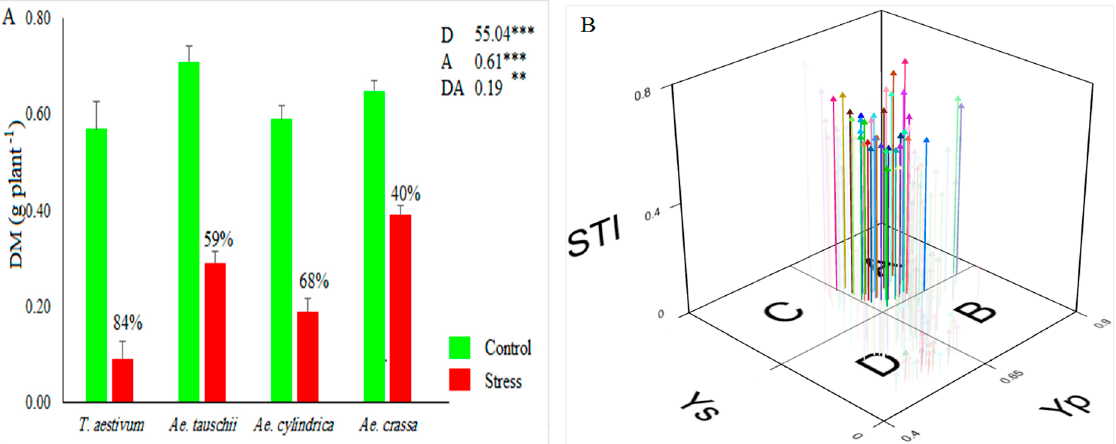
Figure 2. ( A ) Mean value for dry matter (DM) and ( B ) 3D-plot rendered based on dry matters under the control and drought stress conditions (Yp and Ys). ns, **, and *** indicate not significant, significant at p < 0.01, and significant at p < 0.001, respectively. D, A, and DA indicate drought treatment, accessions, and their interaction effects, respectively.